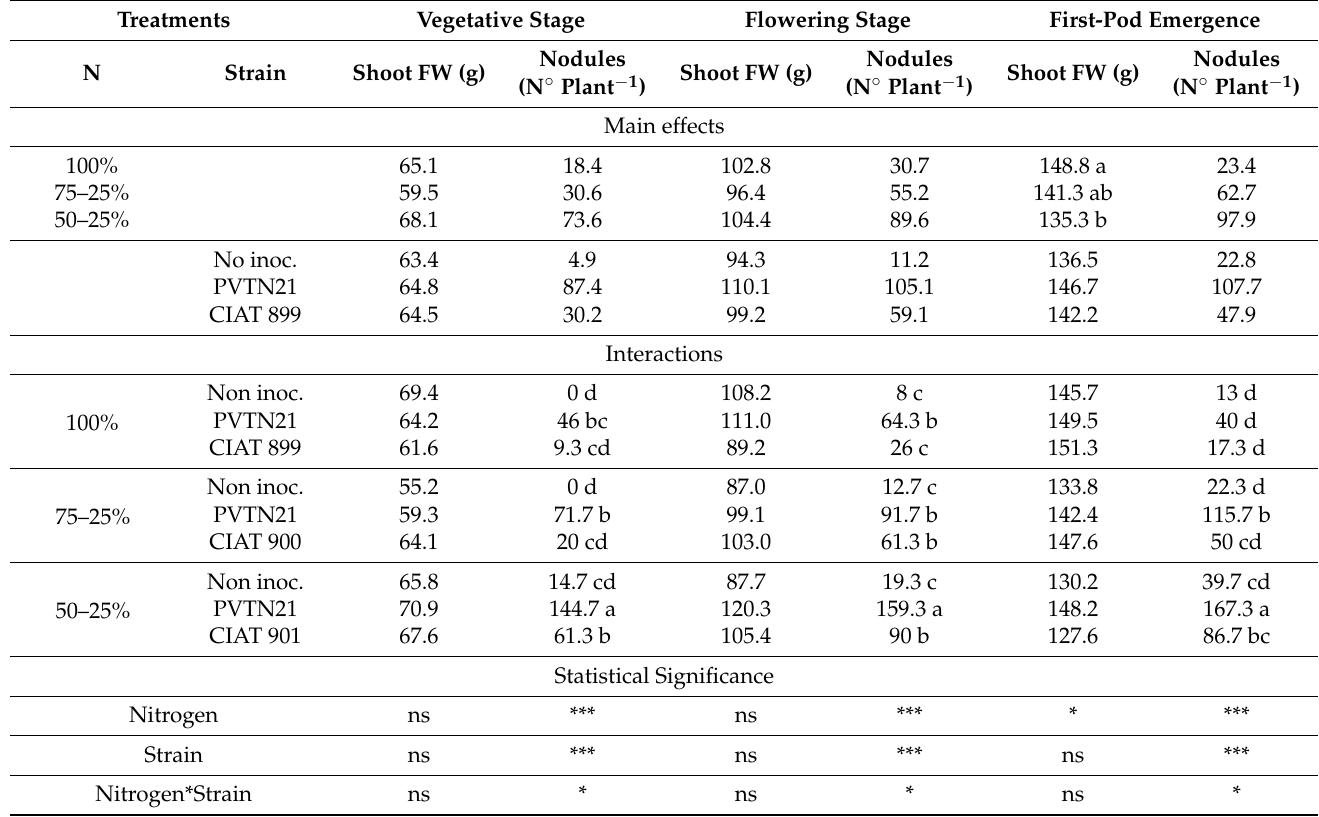
Table 1. Impact of different inorganic-N fertigation schemes and rhizobia inoculants on the growth and nodulation capacity of the common bean ( Phaseolus vulgaris